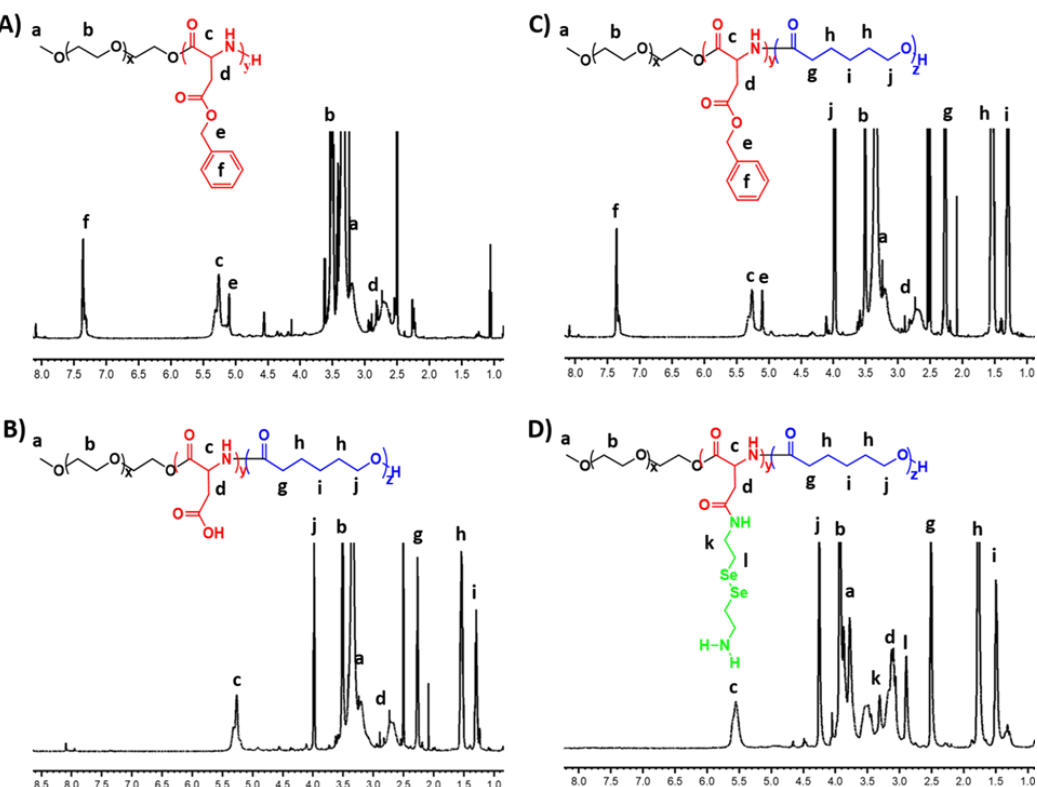
Figure 1. 1 H NMR spectra of mPEG-PBLA ( A ), mPEG-PBLA-PCL ( B ), and mPEG-PLA-PCL ( C ) in DMSO-d 6 ; mPEG-P(LA-DSeDEA)-PCL ( D ) in CF 3 COOD.